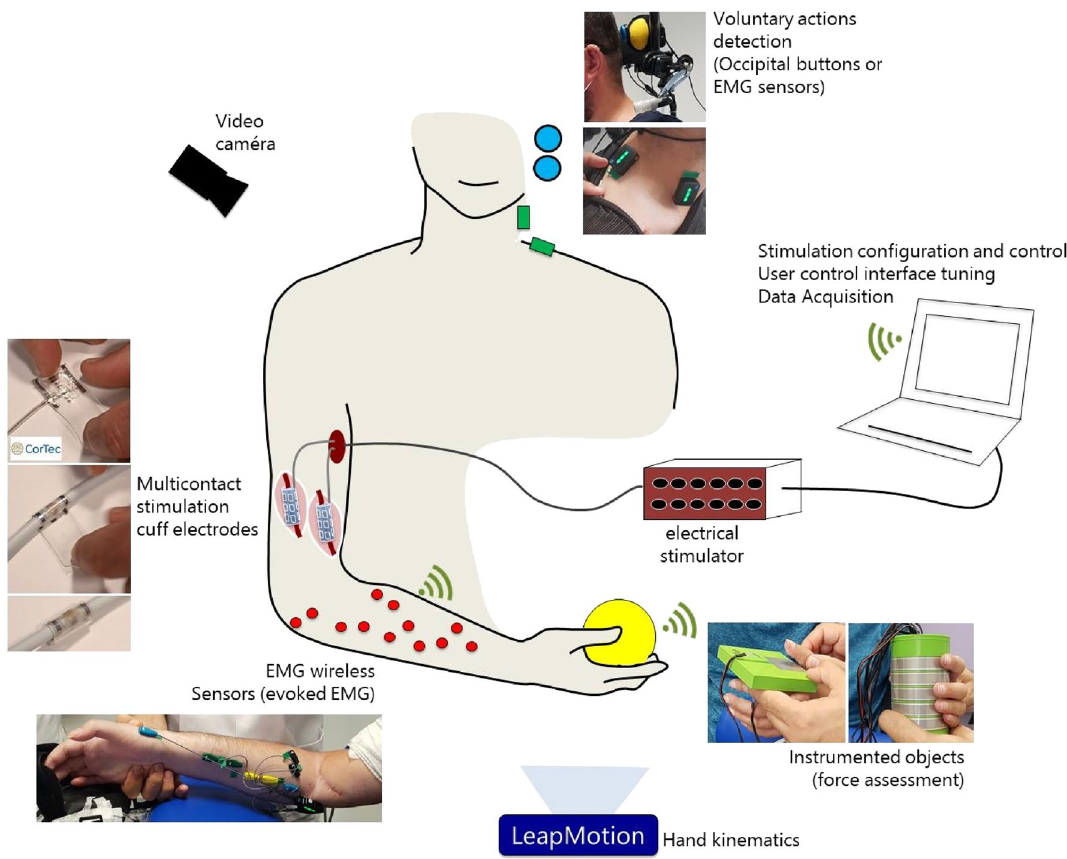
Figure 6. Setup description. An experimental platform was developed to control the stimulation delivered to 2 neural epineural electrodes implanted around the median and radial nerves. Evoked electromyography, video, evoked movement kinematics and grasping forces were recorded. The participants used voluntary muscle contractions or occipital buttons to trigger different stimulation